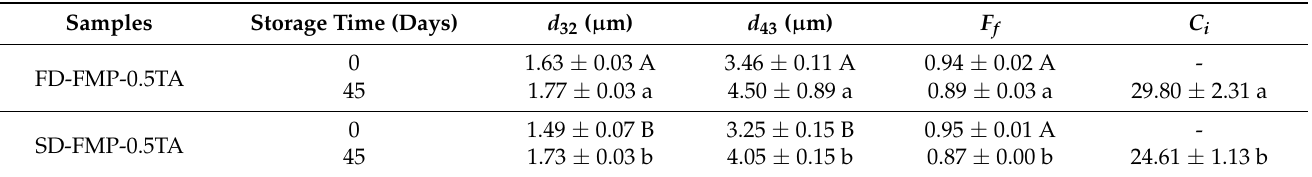
Table 3. Droplet size and stability of oil-in-water emulsion stabilized by freeze-dried (FD)